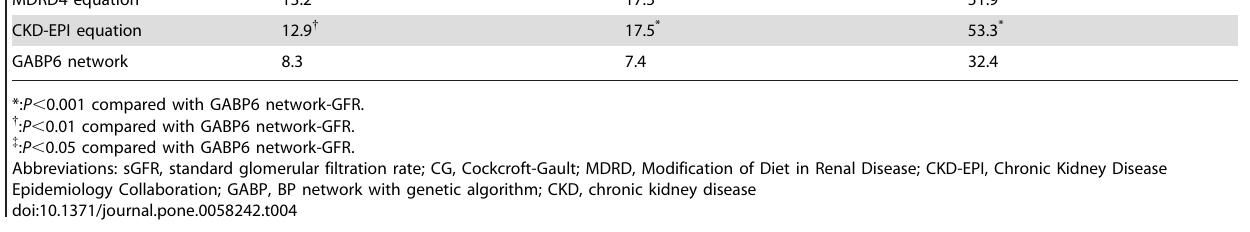
Misclassification rate for the diagnosis of